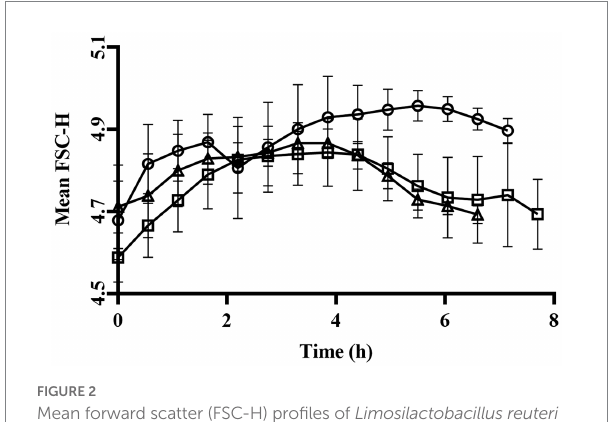
FIGURE 2 Mean forward scatter (FSC-H) profiles of Limosilactobacillus reuteri DSM 17938 during cultivation in air sparged, non-sparged or N 2 sparged cultivations. Air sparged (open circle), non-sparged (open square) and N 2 sparged (open triangle) Data are mean ± SD of three biological replicates for three conditions.